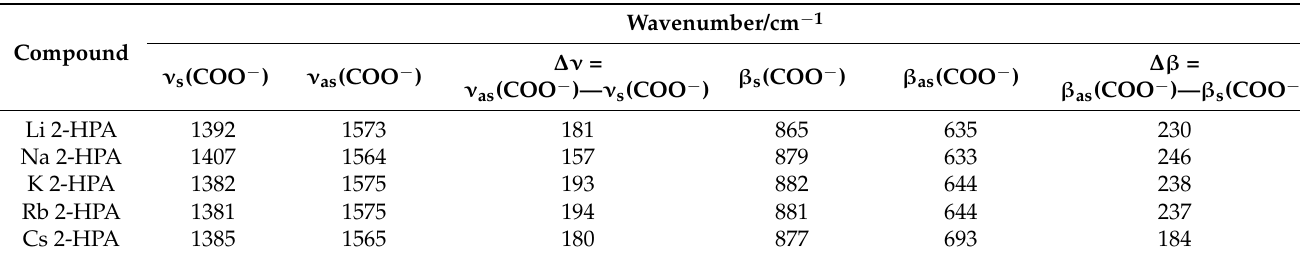
Table 2. Comparison of spectral parameters (stretching and deformation vibrations of the carboxylate anion) from the FT-IR spectra of 2-HPAA alkali metal salts.